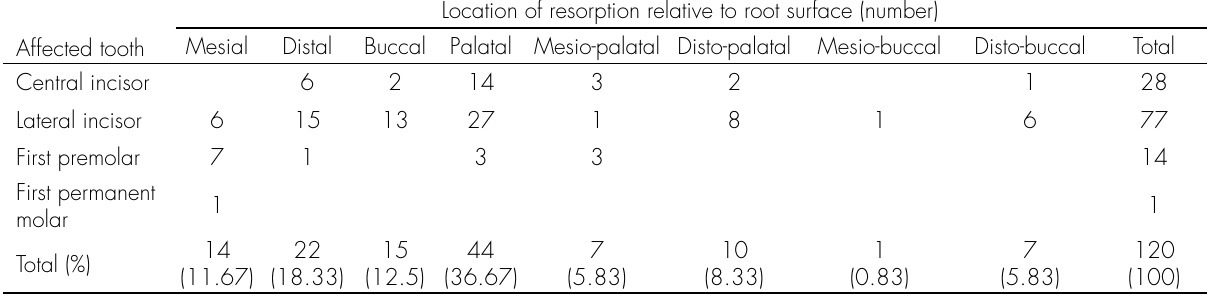
Table V. Distribution of degree (severity) of resorption lesions.